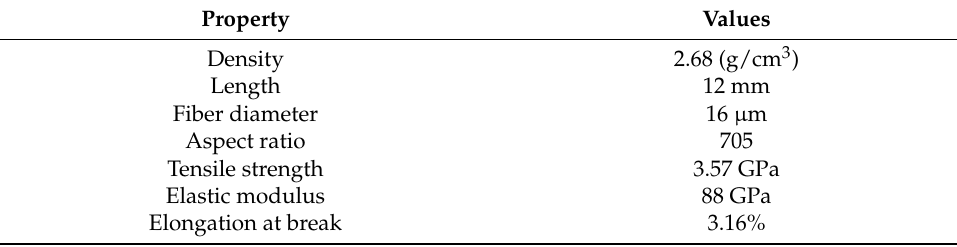
Table 2. Properties of basalt